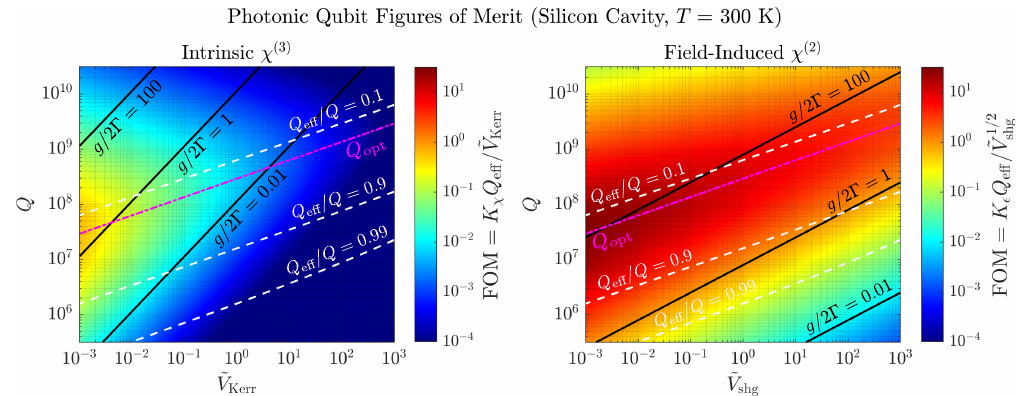
FIG. 5. Performance of room-temperature all-optical qubits using bulk χ ð 3 Þ (left) or electric-field-induced χ ð 2 Þ (right) nonlinearities in silicon microcavities as a function of loaded cavity quality factor Q at λ 0 ¼ 2 . 3 μ m and the relevant normalized nonlinear mode volume ˜ V ˜ V ˜ V ˜ V ( and , assumed to be equal to T Kerr ¼ shg coupling rate g to the composite decay and thermal dephasing rate 2 Γ ≈ Q ). These competing characteristics yield an optimum quality factor Q ¼ Q dephasing ( Q eff diffusion in a homogeneous medium is